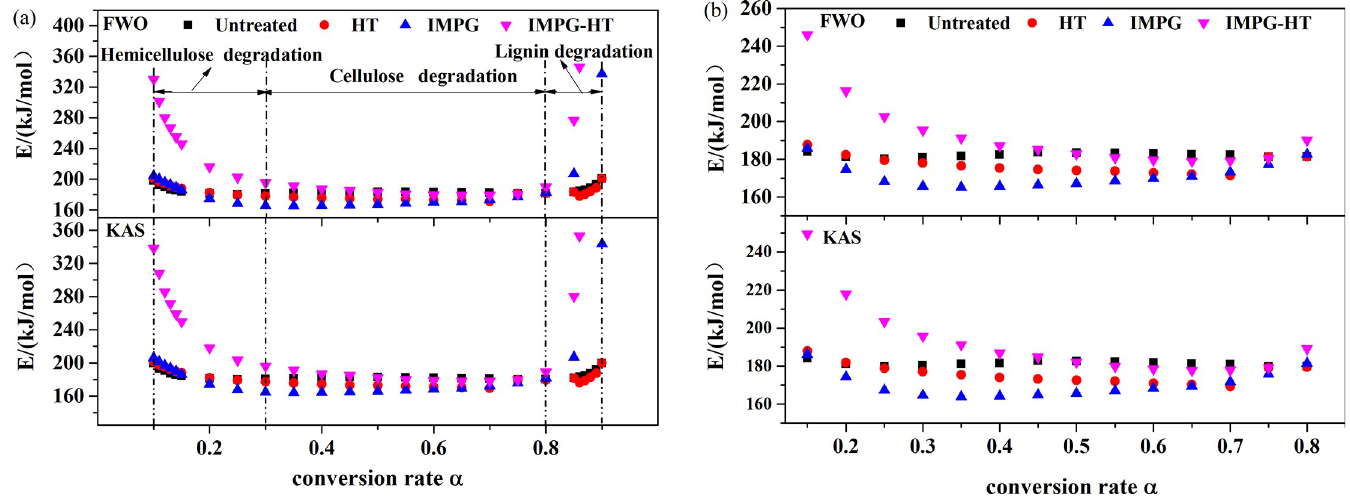
Fig 6. Activation energy ( E ) distributions at different conversion rate ( α ) calculated by the FWO and KAS methods. (a) E distributions for samples at 0.10 < α < 0.90; (b) E distributions for samples at 0.15 < α < 0.80.